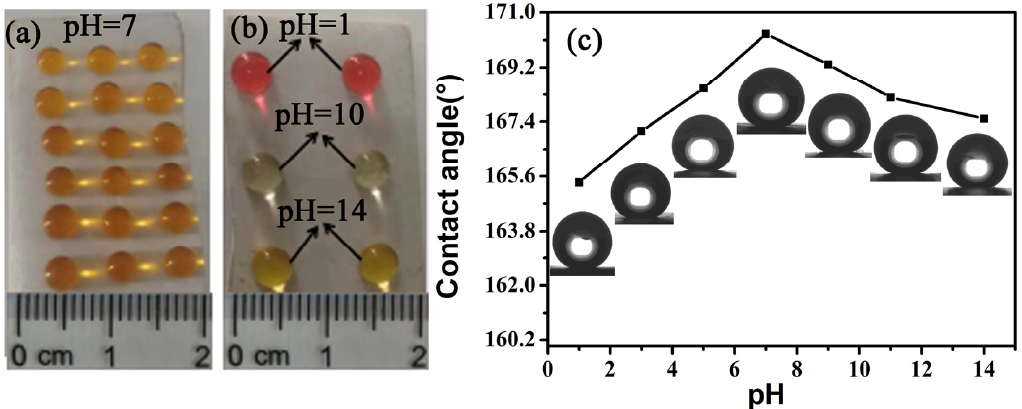
Figure 11. ( a,b ) Digital photographs of water droplets with different pH on the superhydrophobic glass-ceramic surface and ( c ) changes of WCA after the samples were immersed in H 2 SO 4 and NaOH solutions (pH = 1, 3, 5, 7, 9, 11, 14) for 48 h.